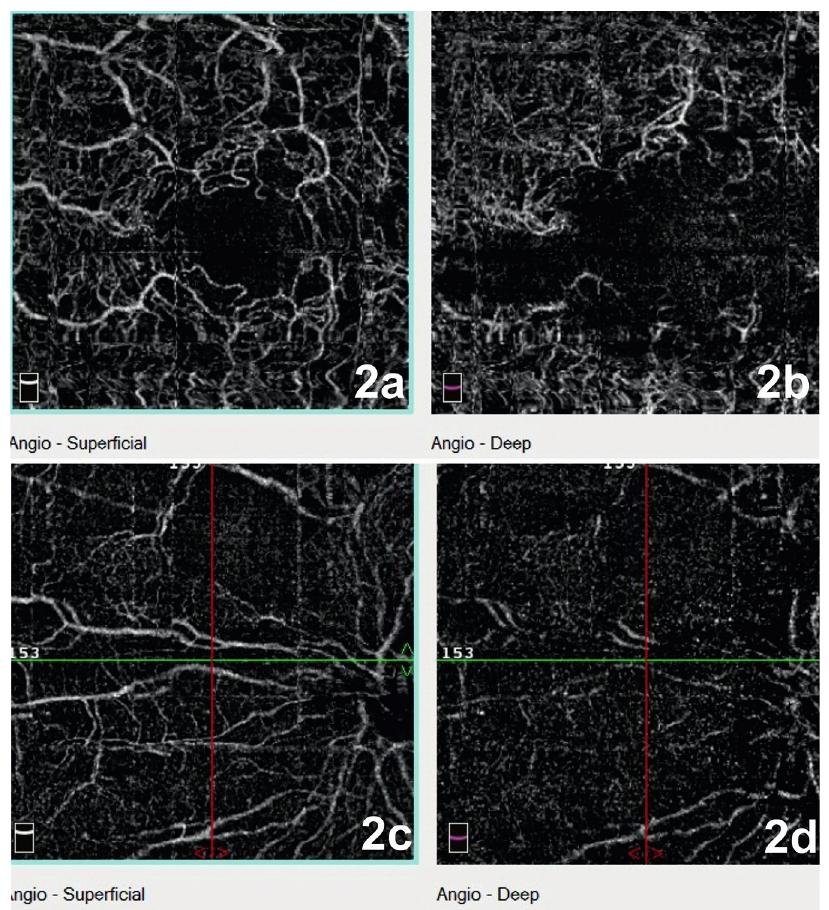
Figure 2. a. Colour fundus photograph of the left eye at first visit showing multiple retinal arteriolar and venous occlusions and few scattered retinal hemorrhages mid peripherally. b. Fluorescein angiography of the left eye at first visit shows absence of filling of dye in posterior and peripheral retina with hyperfluorescent column (marked with white arrow) at junction of abrupt obstruction of